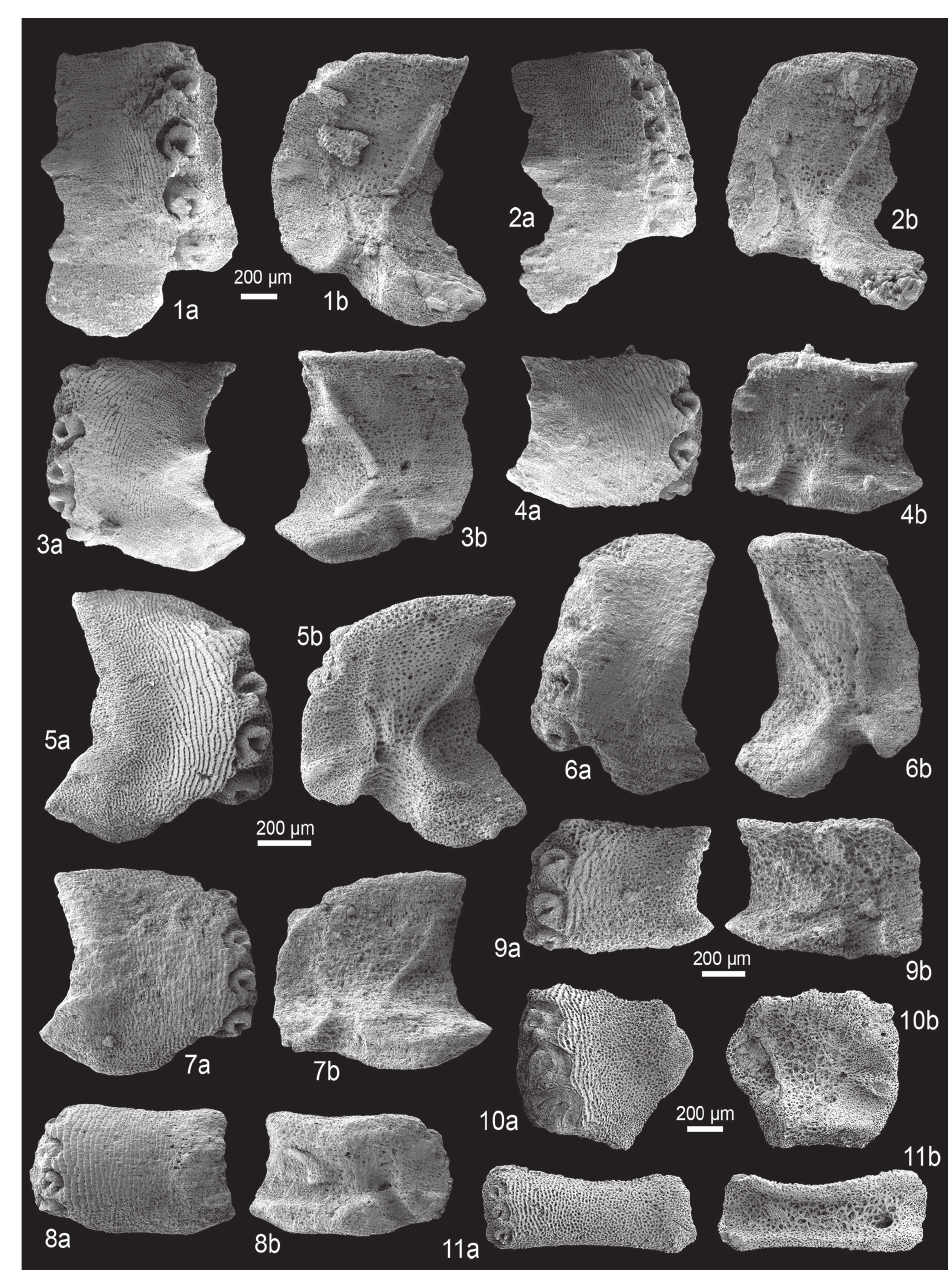
Fig. 28. Fossil lateral arm plates (LAPs) of ophiacanthid brittle stars in external (a) and internal (b) views. 1-4. Dermocoma numbergerorum sp. nov. from the middle Oxfordian (Late Jurassic) of Foug, France. 1. GZG.INV.78695 (holotype), proximal LAP. 2. GZG.INV.78696 (paratype), proximal LAP. 3. GZG.INV.78697 (paratype), median LAP. 4. GZG.INV.78698 (paratype), distal LAP. 5-8.